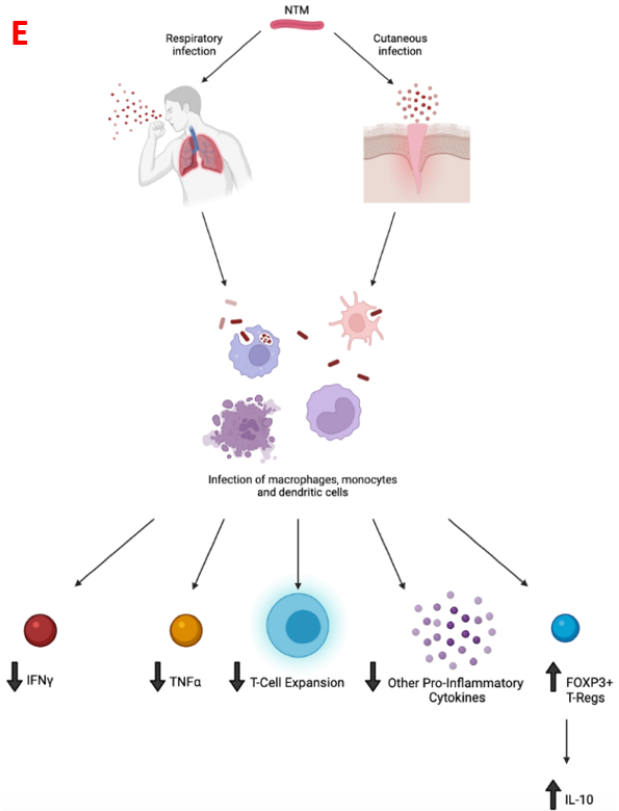
Figure 1. ( A , B ): Eleven-year-old child presents with hypopigmented annular rash of the arms, trunk, and face. The lesion is biopsied and shows an infiltrate in the papillary, mid, and deep dermis, with a suggestion of a granulomatous response. There is no evidence of caseating necrosis. On higher magnification there are nodular collections of epithelioid histiocytes with abundant eosinophilic cytoplasm. These aggregates account for the vague granulomatous response. On Ziehl Neelson stain, scarce organisms were noted, and tissue was submitted for PCR analysis. This confirmed the diagnosis of M. leprae . Tissue had not been submitted for cultures. ( A ): H&E stain, 20× magnification. The skin biopsy shows a vaguely granulomatous reaction in the papillary, mid, and deep dermis (blue arrow). There is no evidence of caseating or non-caseating granulomas. ( B ): H&E stain, 60× magnification. Sheets of epithelioid histiocytes are noted with abundant eosinophilic cytoplasm (blue arrow). There is no evidence of granulomas, caseating or non-caseating. There is no evidence of necrosis. ( C , D ): Forty-five-year-old HIV-positive patient with complaints of severe nausea and vomiting undergoes upper GI endoscopy. Lesional tissue of the small bowel is biopsied and submitted for histologic examination. Images are as noted below. The lesional tissue shows large expansions of macrophages with abundant eosinophilic cytoplasm and displaced nuclei. Granulomas, both caseating and non-caseating, were absent. There is no evidence of necrosis. On special stains (Ziehl Neelson stain) scattered organisms morphologically suggestive of mycobacteria were noted. For definitive diagnosis and species identification, tissue was sent for PCR analysis and results were consistent with M. avium intracellulare . Cultures were also positive. ( C ): H&E stain, 20× magnification. Small bowel mucosa shows an expansion of the lamina propria with large accumulations of foamy cells with abundant eosinophilic cytoplasm (blue arrows). There is no evidence of granulomas, caseating or non-caseating. ( D ): H&E stain, 60× magnification. Sheets of foamy macrophages with abundant eosinophilic cytoplasm (blue arrow). ( E ): Infection with NTM via inhalation of aerosolized particles into the respiratory tract or entry through a break in the skin barrier leads to infection of macrophages, monocytes, and dendritic cells and a subsequent decrease in TNF-alpha, IFN-gamma, T-cell expansion, and other pro-inflammatory cytokines thereof. In addition, upregulation of Foxp3+ and Tregs results in increased IL-10 production which promotes intracellular NTM survival within the host.